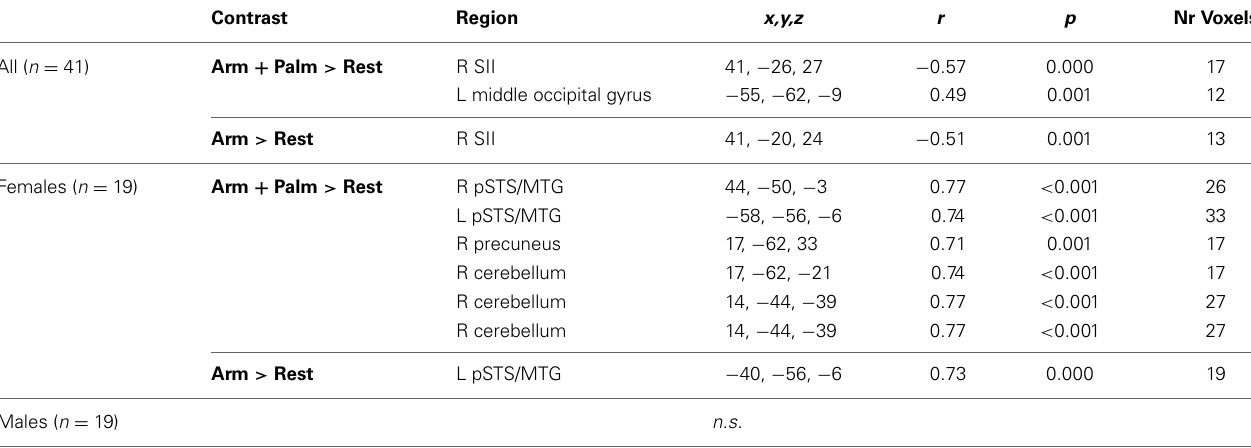
FIGURE 5 | Correlations between brain responses to tactile stimuli ( β values) and age in (A) ipsilateral SII ( p < 0 . 01, k = 12) (both genders combined) and (B) bilateral pSTS/MTG in females ( p < 0 . 01, k = 15). The Table 4 | Regions showing a significant correlation between brain responses to touch and